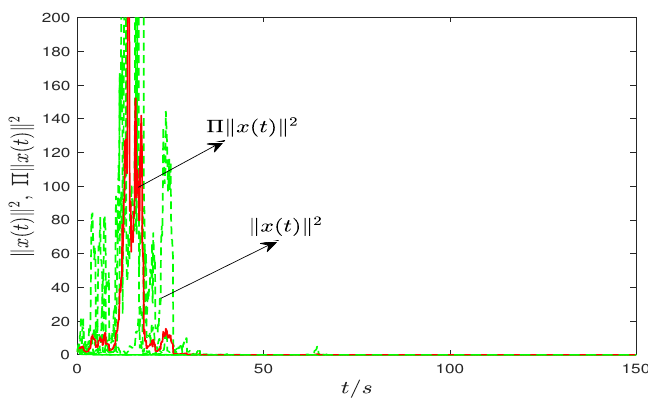
Figure 7. State response curve of the open loop